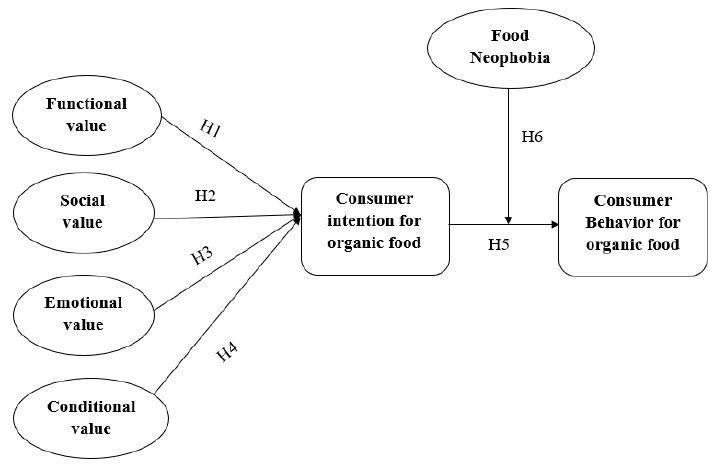
Figure 1. Theoretical Framework.